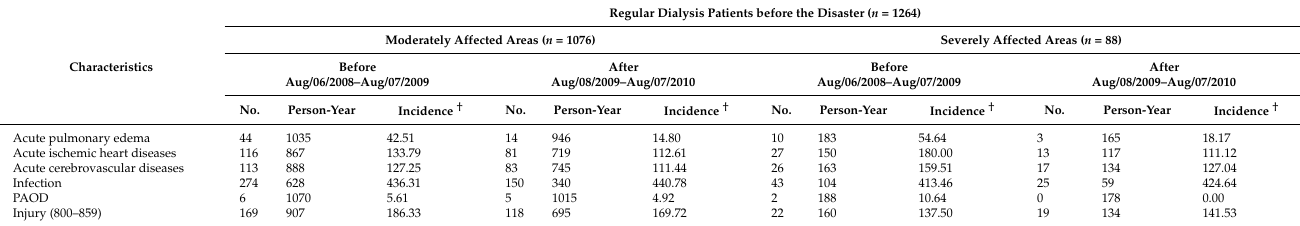
Table 2. Hospitalizations of dialysis patients living in the affected areas before and after Typhoon Morakot.